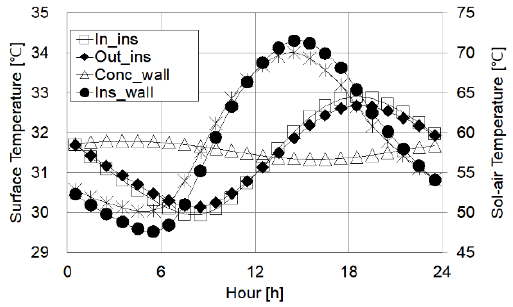
Figure 7. Surface temperature for the material and composition of wall (Unsteady-state).